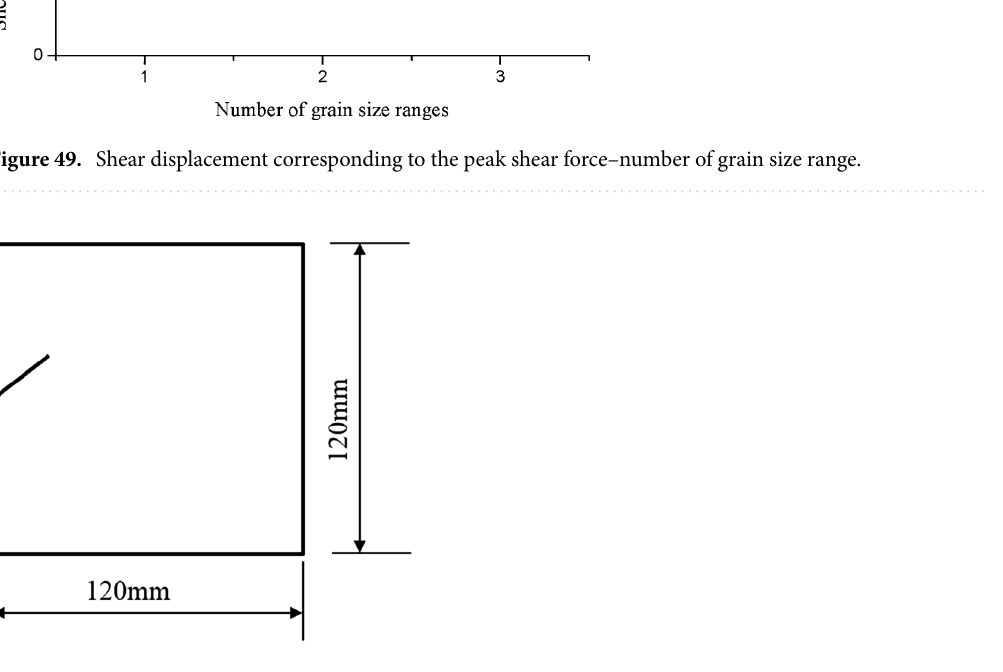
Figure 50. Fissure length 2 cm, horizontal angle of fissure 40° in specimens with different grain size